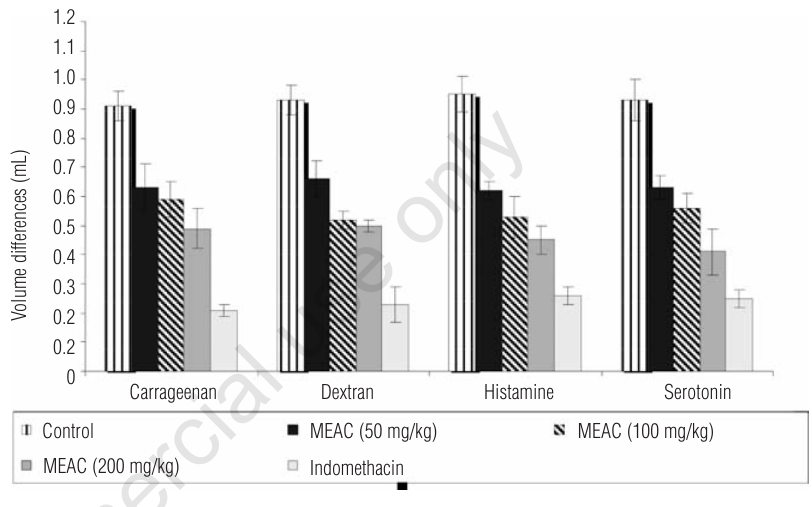
Figure 1. Effect of methanol extract of Anthocephalus cadamba (MEAC) stem bark on carrageenan-, dextran-, histamine- and serotonin-induced pedal edema in rats. Difference of mean of edema volume (mL) between control and treatment values at dif- ferent doses ± S.E.M. Variation compared to the control animals. ANOVA followed by Student’s t-test.